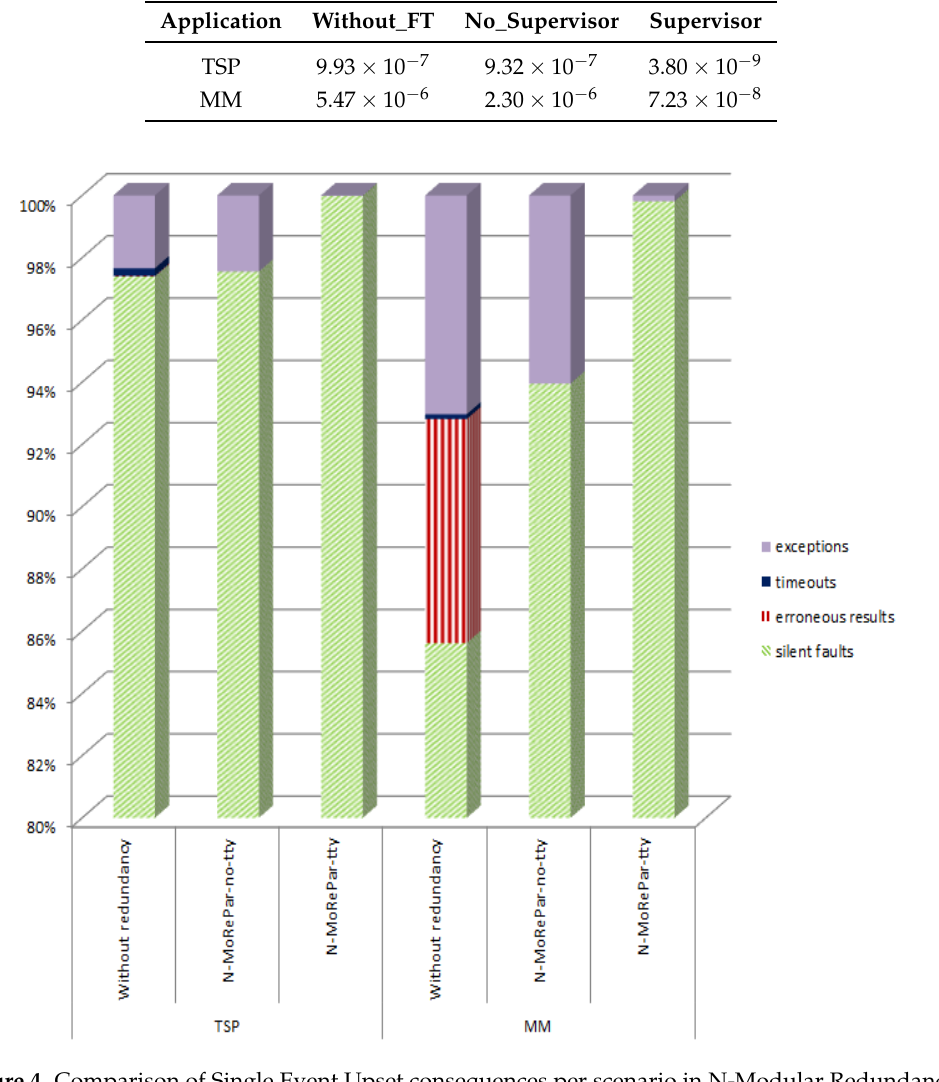
Figure 4. Comparison of Single Event Upset consequences per scenario in N-Modular Redundancy and M-Partions